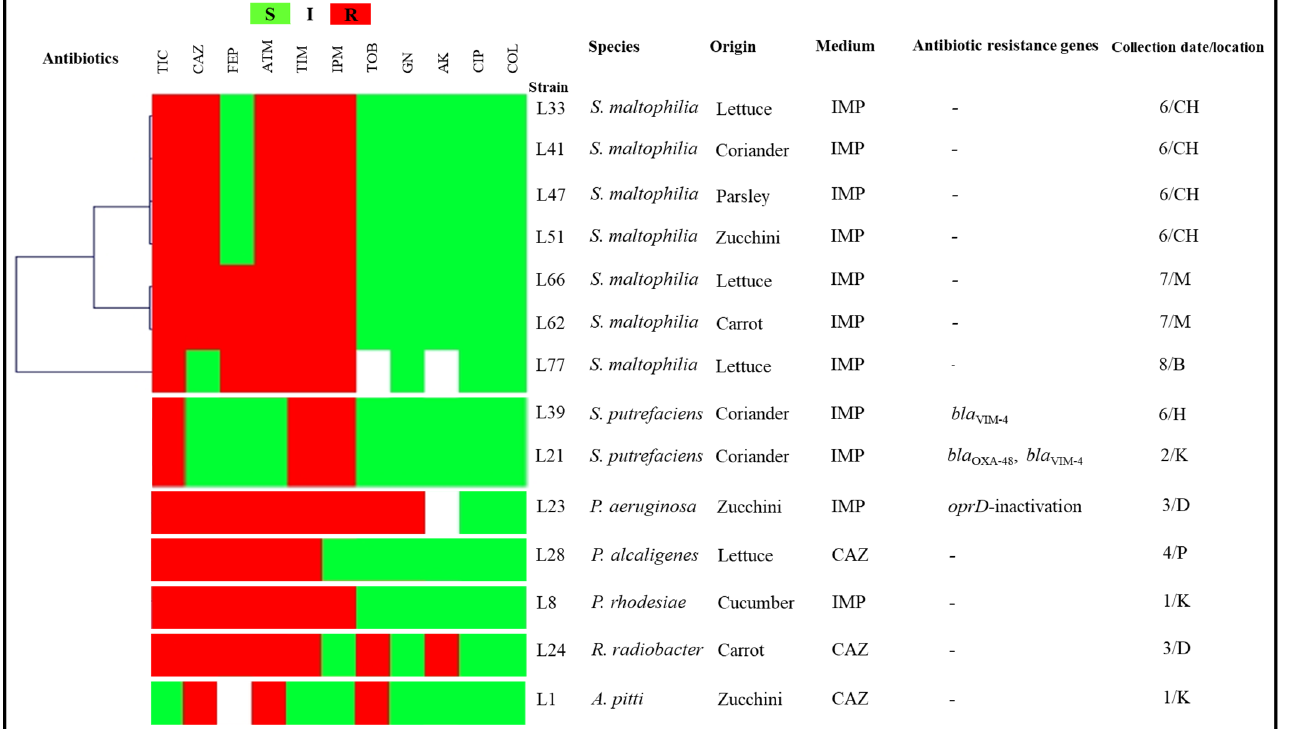
Figure 2. Antibiogram results, β -lactam resistance mechanisms and origins of our non-fermenting isolates clustered using the MultiExperimentViewer (MEV) software version 4_6_2. TIC, ticarcillin;